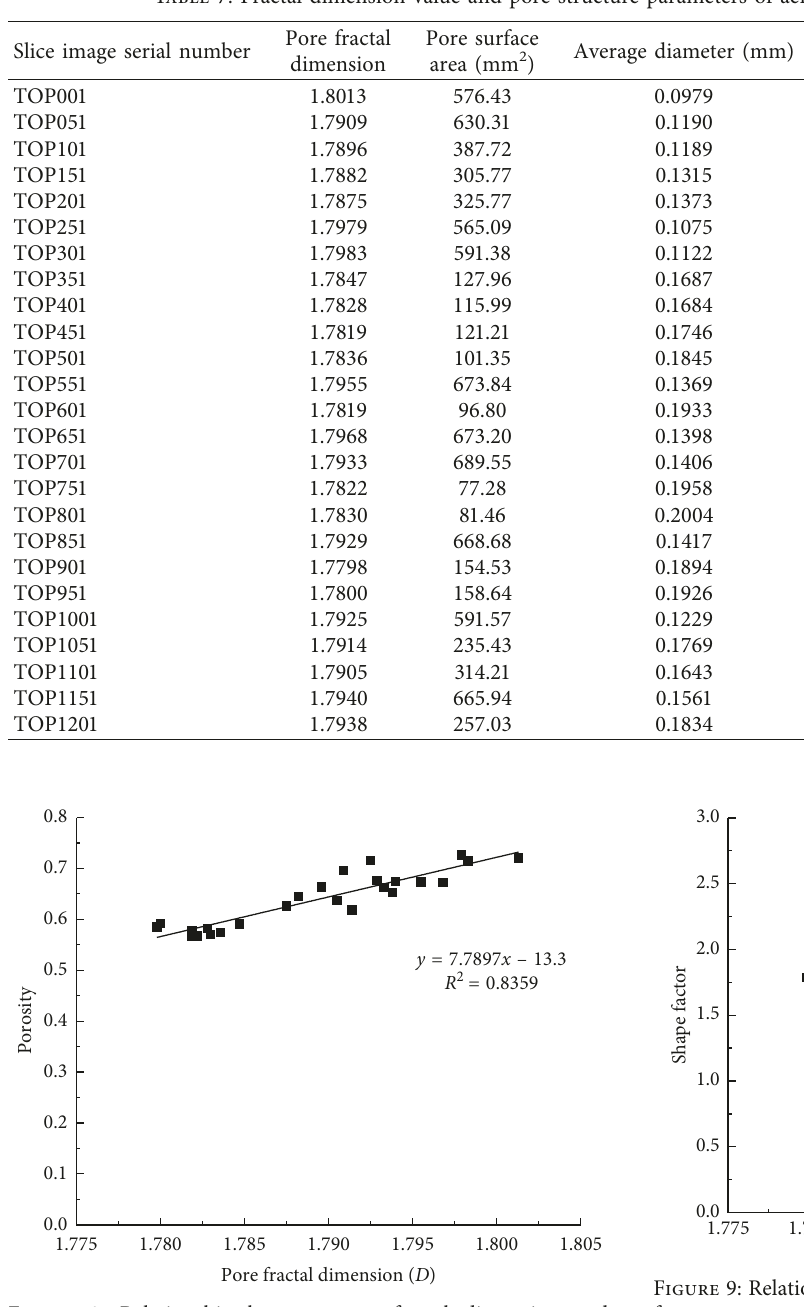
Table 7: Fractal dimension value and pore structure parameters of aerated concrete block slice images.